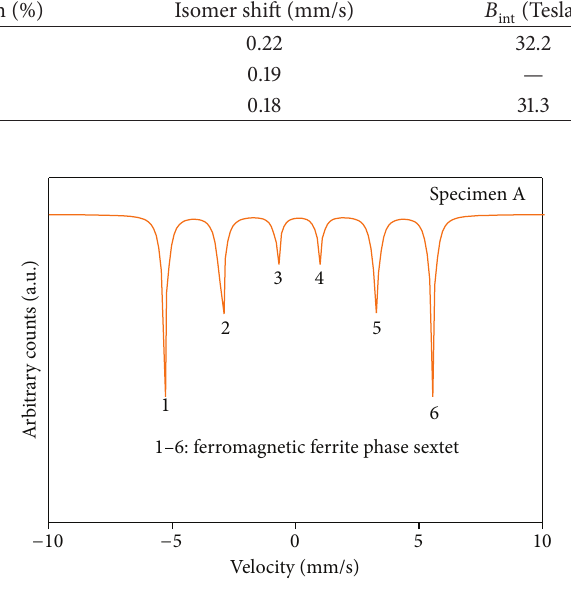
Figure 4: M¨ossbauer spectrum of specimen A.